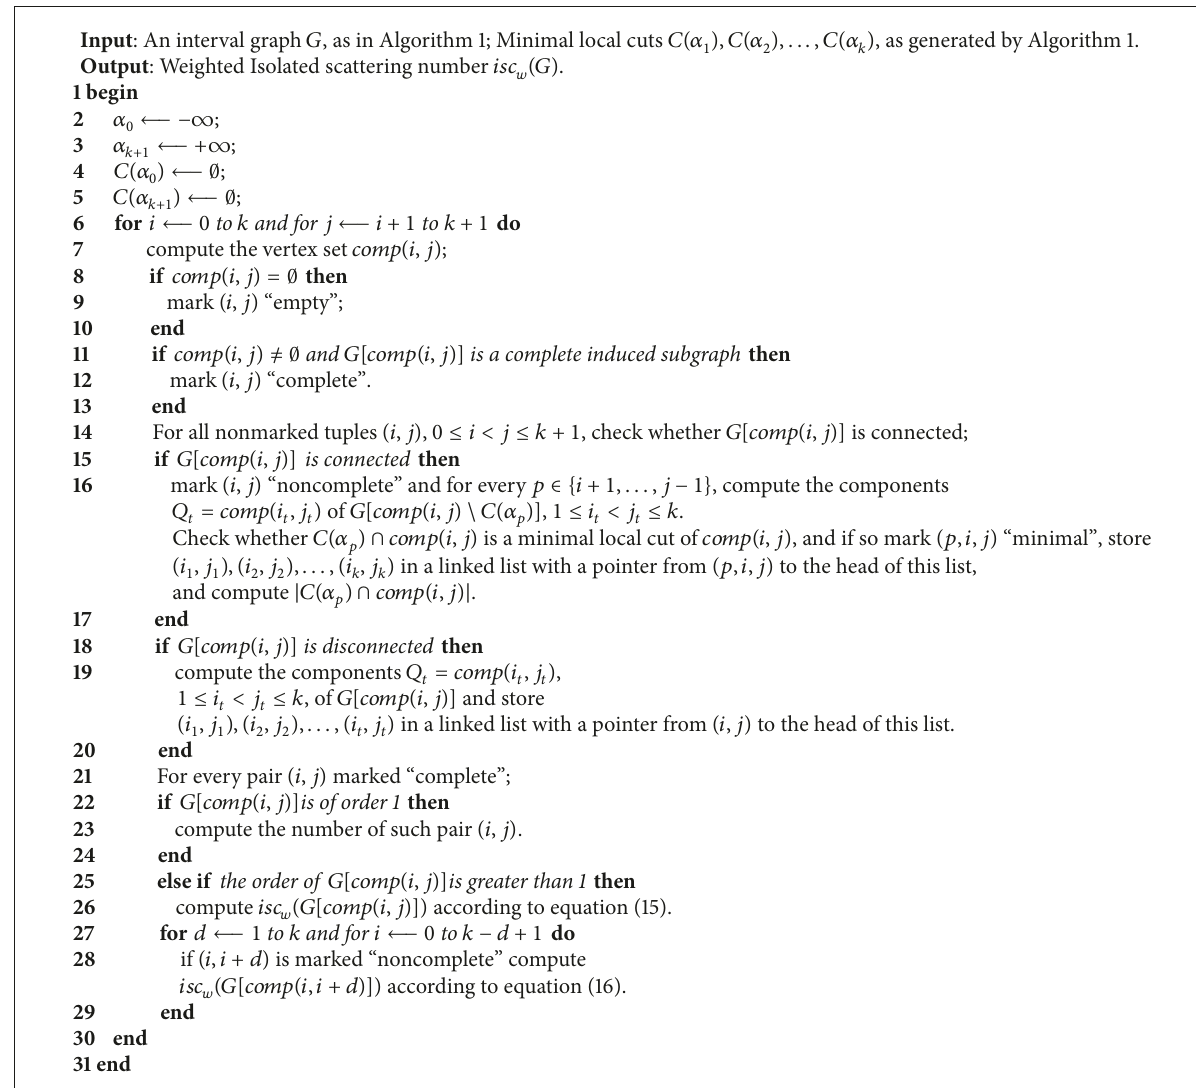
Algorithm 2: Algorithm weighted isolated scattering